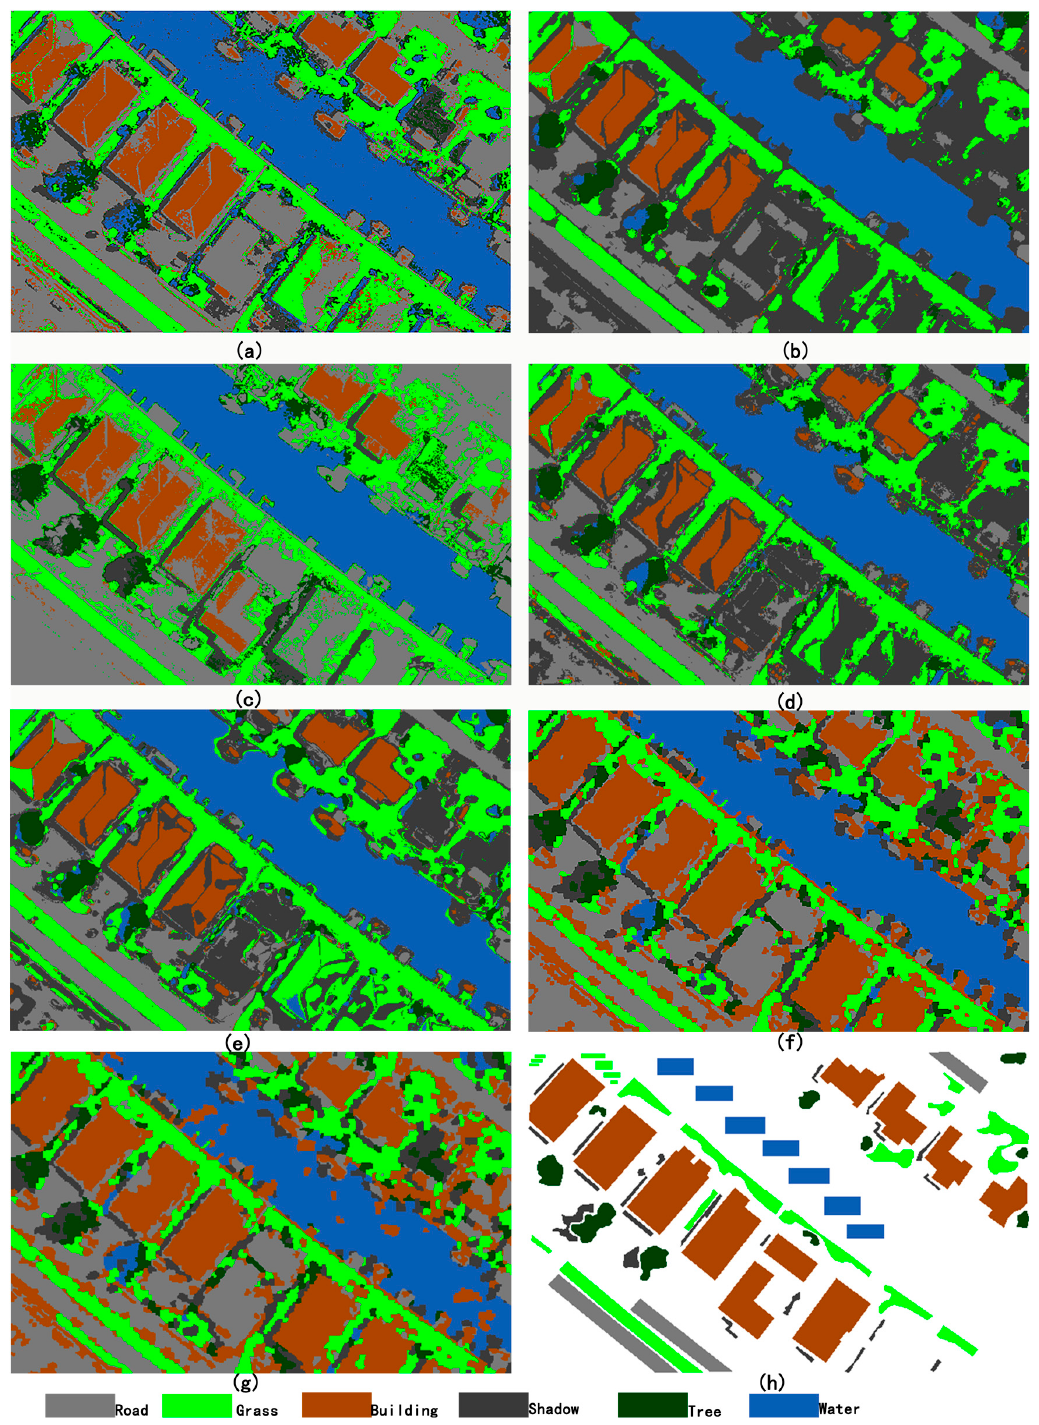
Figure 7. Classification maps obtained from various feature types of aerial image using SVM classifiers: ( a ) spectral feature only; ( b ) M-MP spatial-spectral feature; ( c ) AP spatial-spectral feature; ( d ) RFs Spatial-spectral Feature; ( e ) RGF Spatial-spectral Feature; ( f ) proposed object-based, spatial-spectral feature; ( g ) OCI spatial-spectral feature; ( h ) the ground truth.